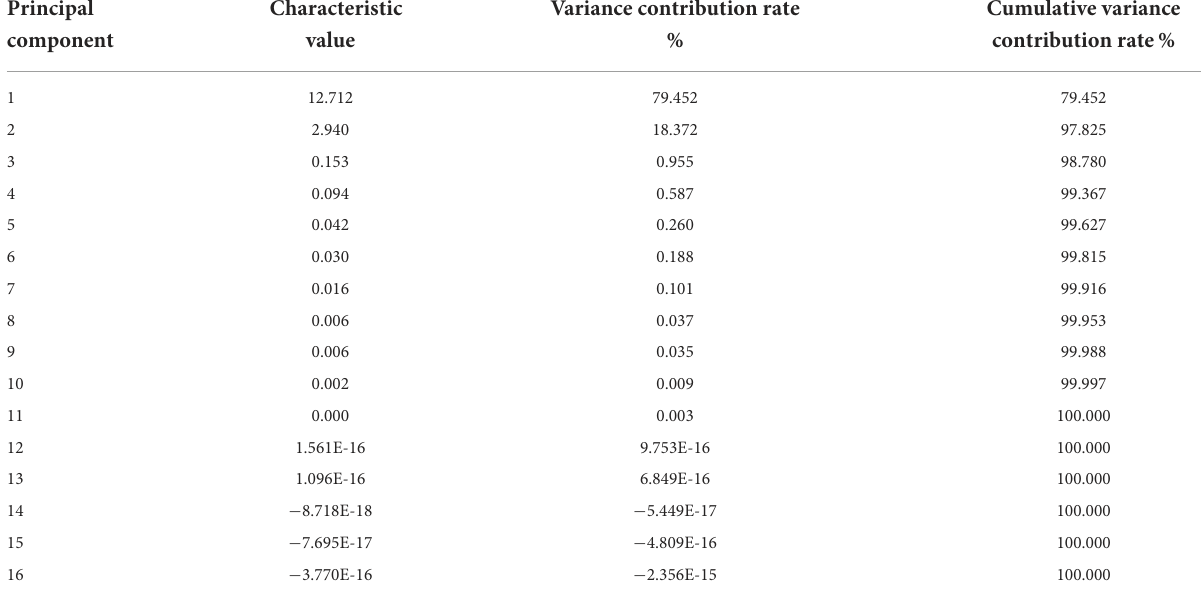
TABLE 6 Initial eigenvalue and cumulative variance contribution rate of principal